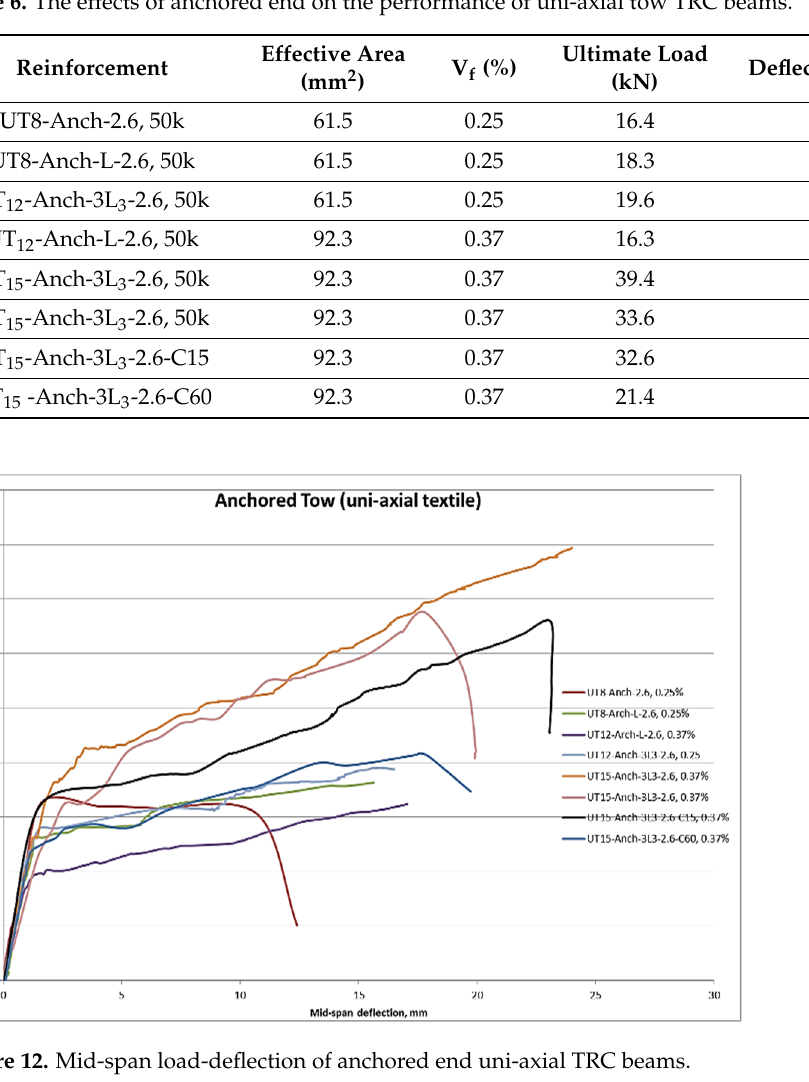
Table 6. The effects of anchored end on the performance of uni-axial tow TRC beams.